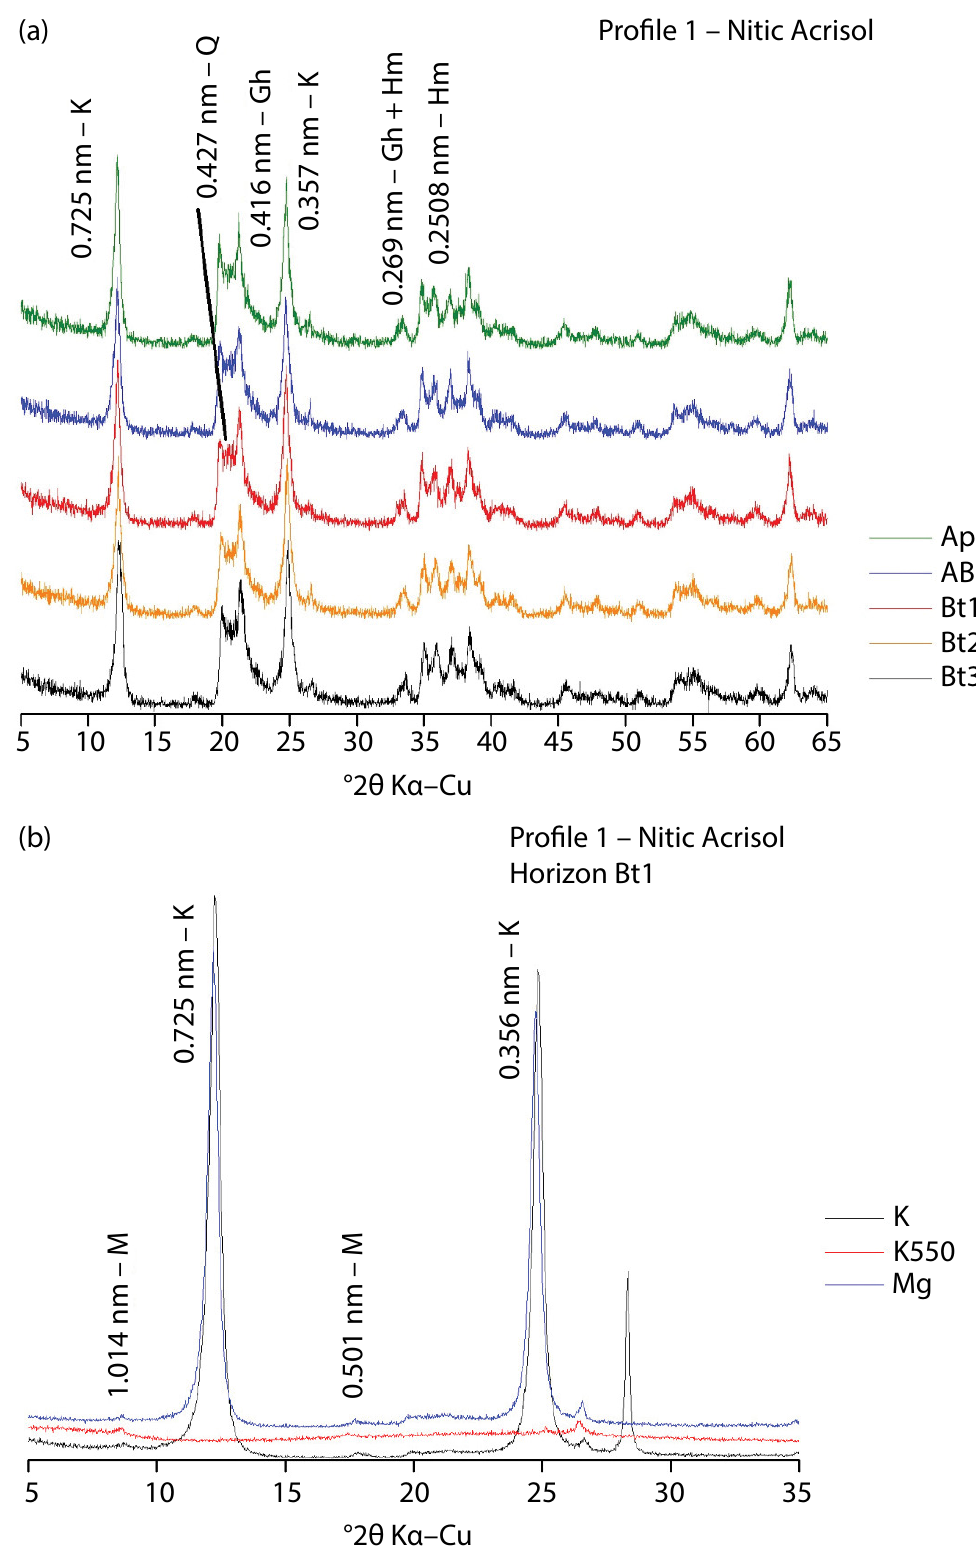
Figure 3. X-ray diffraction (XRD) of the natural clay fraction in the form of oriented aggregates from all horizons of P1 (a), and of the clay fraction from Bt1 horizon of P1 (b). The XRD of P1 represents all the profiles studied since the XRD of all horizons and profiles were